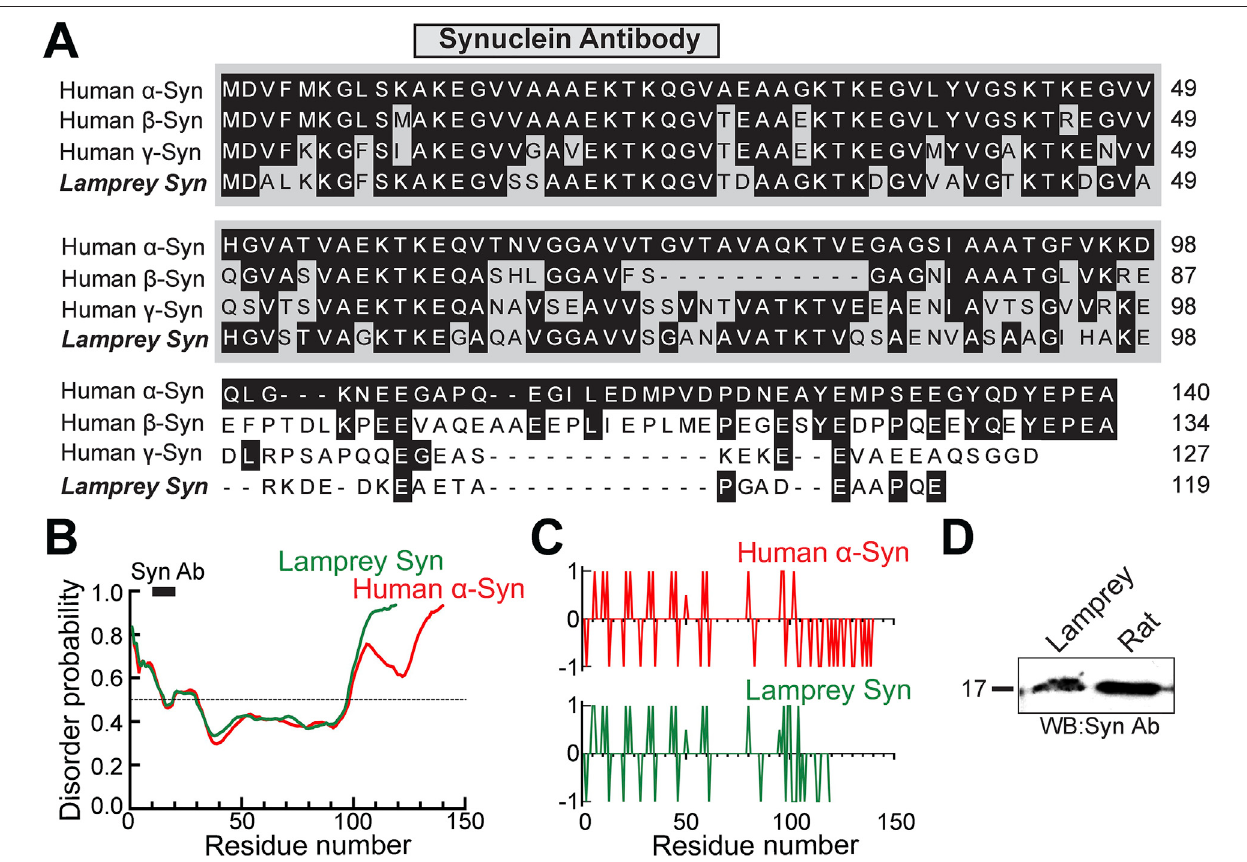
FIGURE1| Lamprey and humansynucleins arehighly conserved. (A) Multiplesequence alignmentofhumansynuclein ( α , β , γ )and lamprey γ -synuclein (GenBank (JN544525.1). Black boxes indicate amino acid residues that are identical to human α -synuclein. The N-terminal domains (gray) are the most conserved sequences amongst synucleins. The epitope of the synuclein antibody used in this study is indicated (anti-pan-synuclein, ab6176 Abcam). (B) Disorder probability of human α -synuclein and lamprey γ -synuclein are nearly identical, even though the lamprey sequence is shorter. Sequences above the 0.5 probability threshold are predicted to be disordered, while those below are structured. Graphs were generated using PrDOS. Black bar indicates the Synuclein Ab epitope. (C) The charge distributions of human α -synuclein and lamprey γ -synuclein proteins are also nearly identical. Positively- and negatively-charged residues are indicated by + 1 and − 1, respectively. Plots were generated using EMBOSS. (D) The pan-synuclein antibody, which was raised against the N-terminal domain of human α -synuclein, recognizes monomeric synuclein in both rat brain and lamprey CNS lysates.